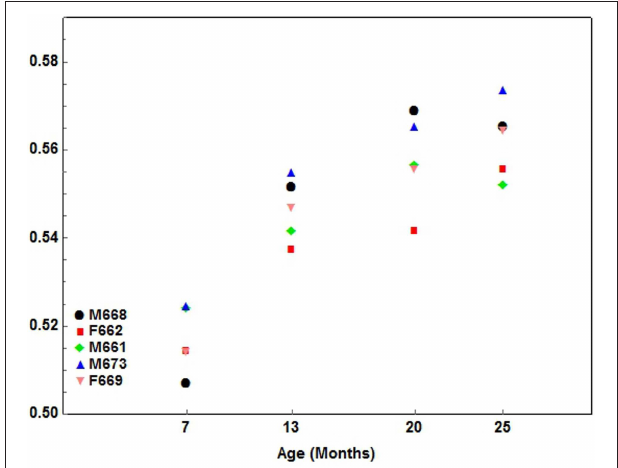
FIGURE 6 | A scatterplot showing the development pattern of the Facial1 index (Facial length1/Condylobasal length) in the 5 cheetah cubs from 7 months of age at ∼ 6-month intervals until they were 25 months of age. Each color presents a different cub as indicated.